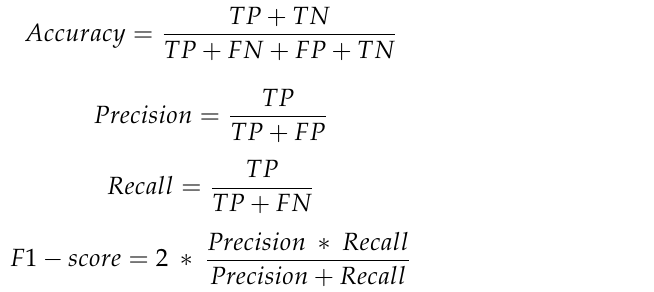
trograms than did the traditional PCA.